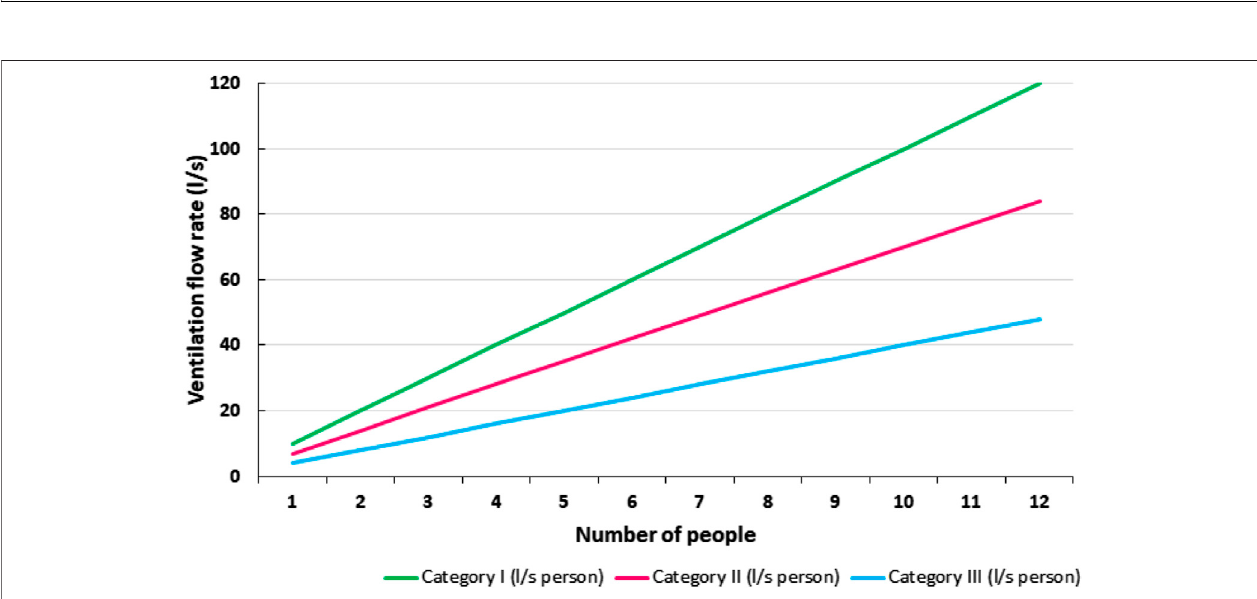
FIGURE 3 | Relationship between ventilation fl ow rate and people (EN 16798 – 2 method